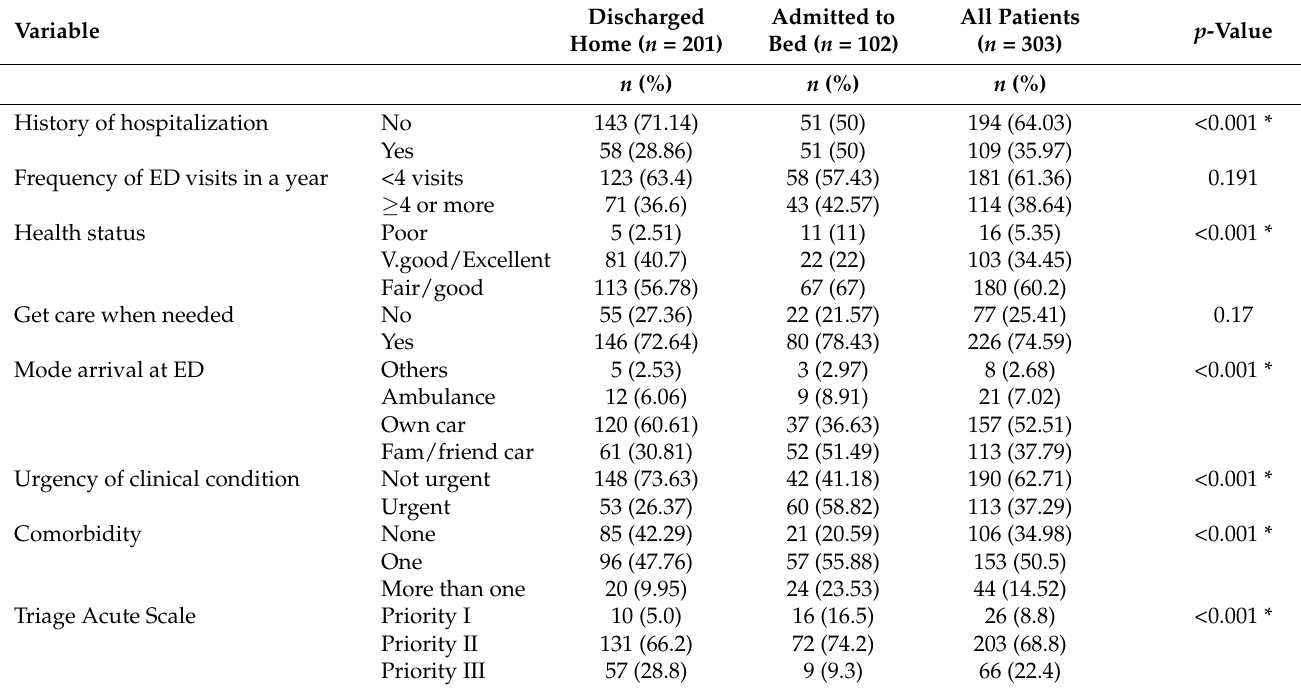
Table 2. Patients’ clinical conditions by disposition decision.